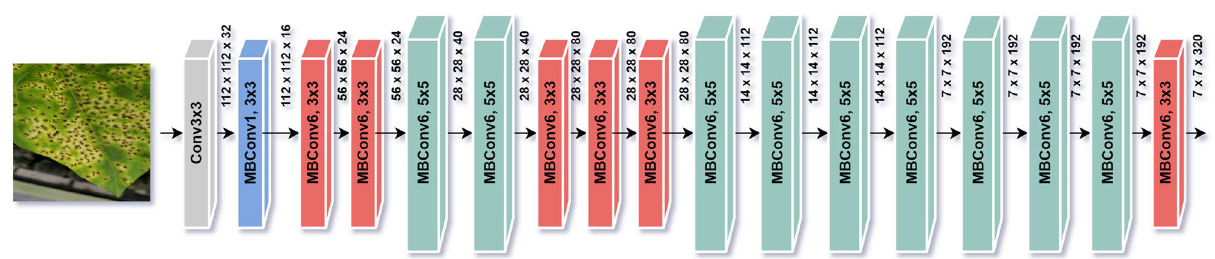
Figure 6. The architecture of the Xception model with a sample input image and 14 modules.